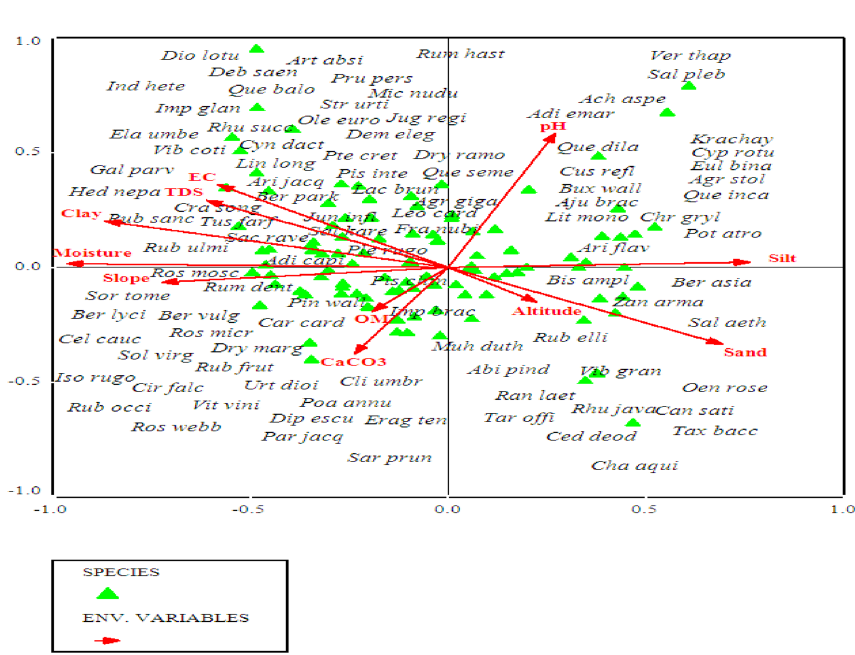
Figure 10. Canonical correspondence analysis (CCA) of 114 plant species in relation to measured environmental